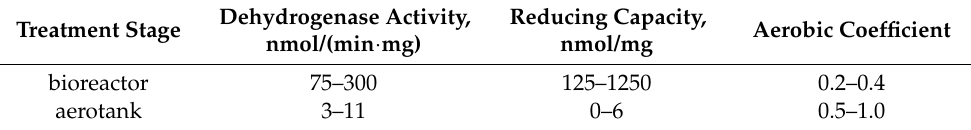
Table 2. The results of industrial monitoring of biofilm and activated sludge